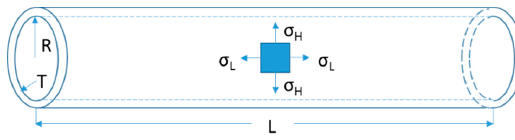
Table 1. (cid:2026) (cid:3009) of PET graft under each inner pressure.